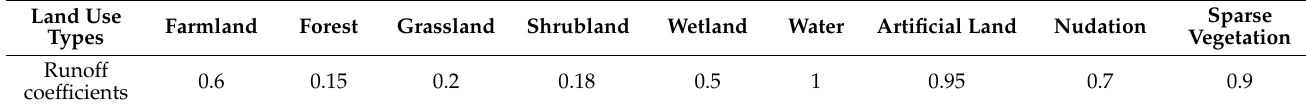
Table 3. Runoff coefficients of various land use